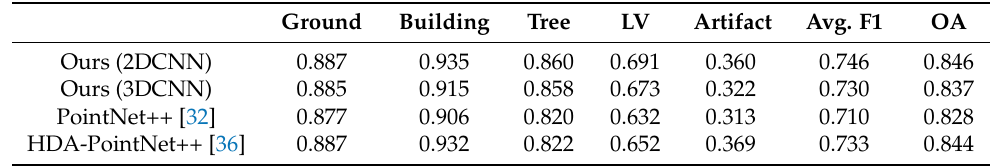
Table 14. Comparison of F1 scores and OA on the LASDU dataset with respect to current state-of- the-art